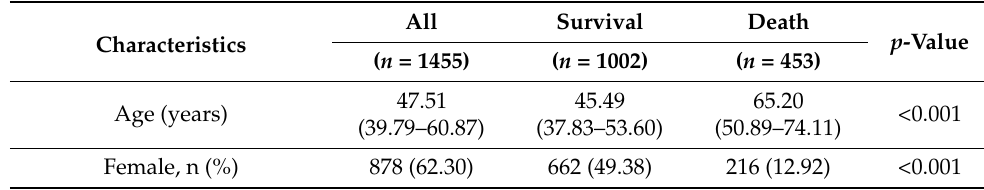
Table 1. Baseline characteristics of 1314 U.S. adults with metabolic syndrome (MetS) in NHANES